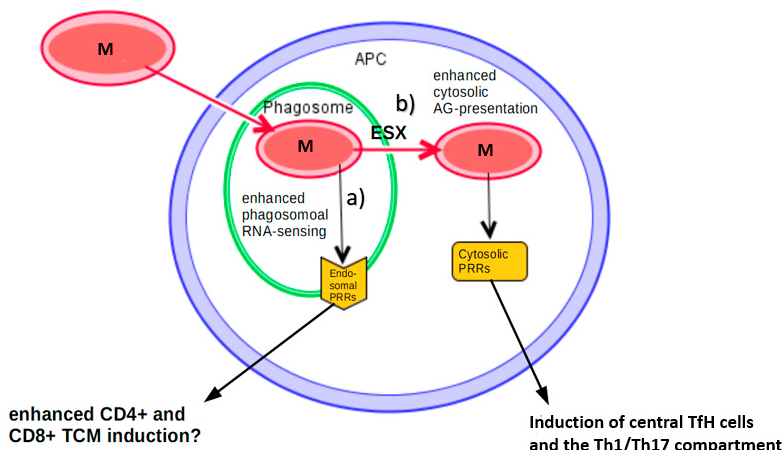
Figure 3. Approaches to improve vaccination against mycobacterium tuberculosis (MTB). After intake of a mycobacterium (M) into human phagosomes, ( a ) one approach is to enhance signaling from endosomal RNA receptors, which eventually might lead to an enhanced induction of CD4 + and CD8 + T-cells [20,120]. ( b ) Another approach could be to enhance antigens in the cytosol to trigger a stronger immune response by cytosolic RNA receptors, potentially leading to an increased induction of central TfH memory cells, as well as the Th1 / Th17 compartment [60,122,123].